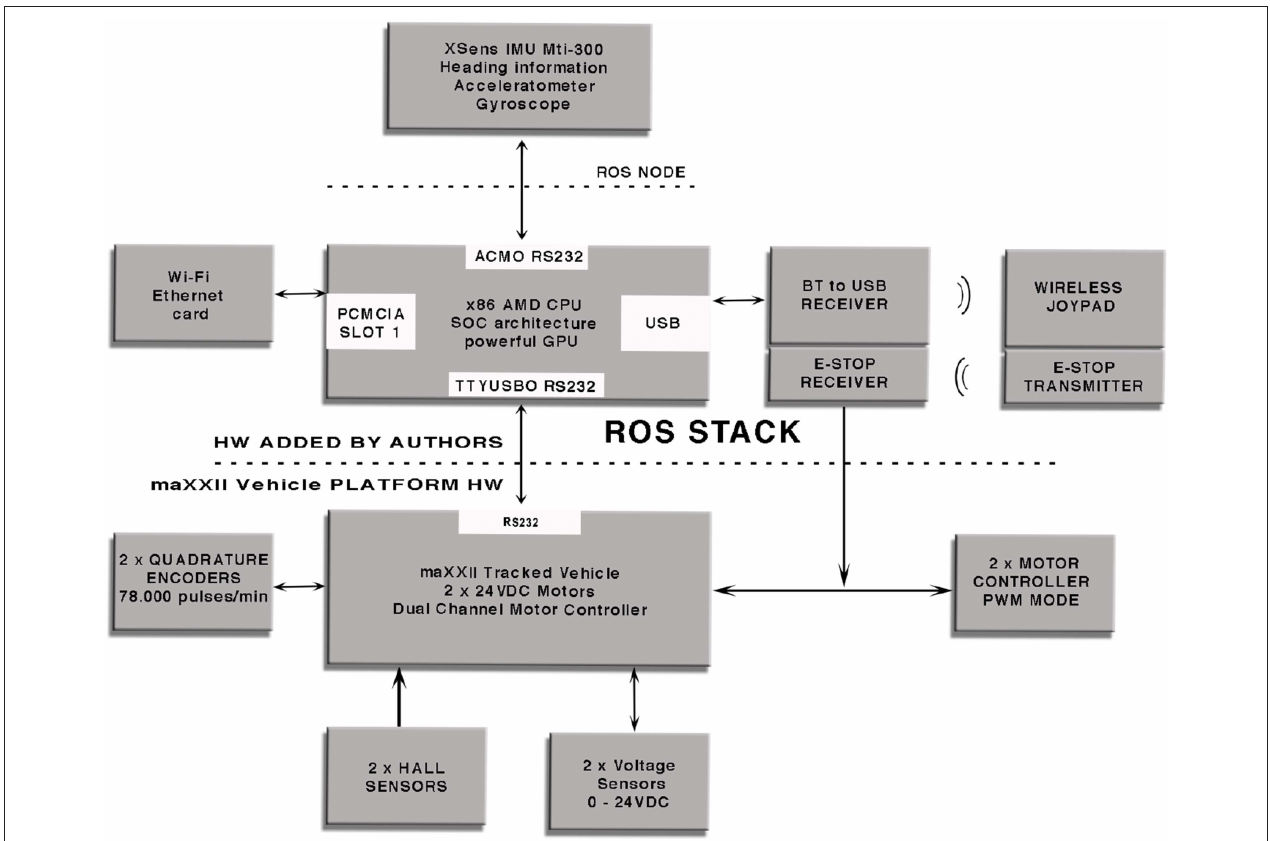
FIGURE 7 | Functional block diagram for the used